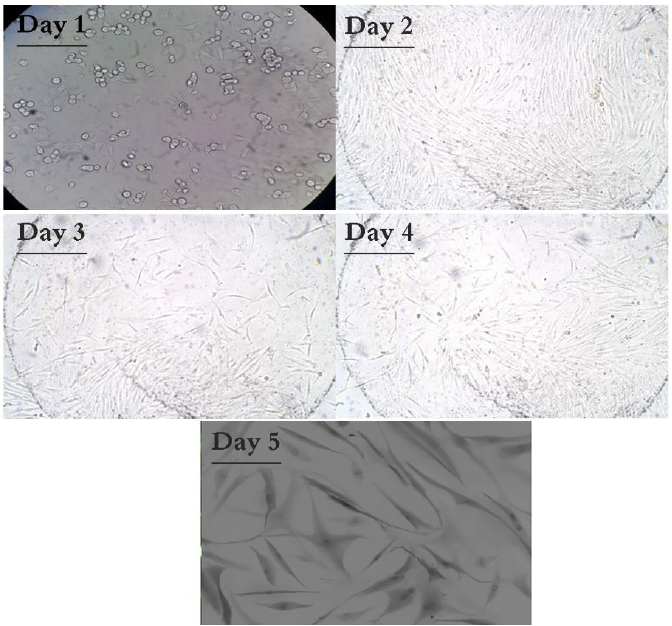
Figure 4. The morphology of fibroblasts from the first passage at different days (×40 magnification for days 1 to 4 and ×100 magnification for day 5).